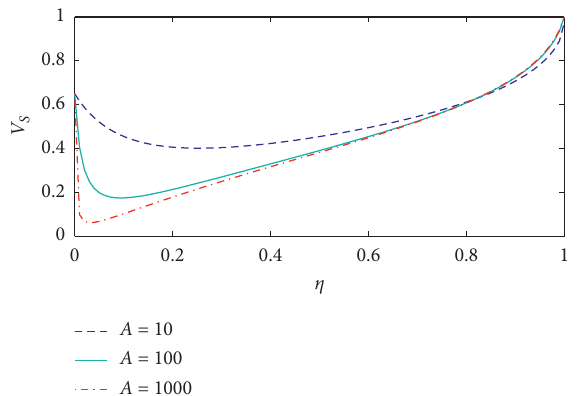
A � 100, S versus η for